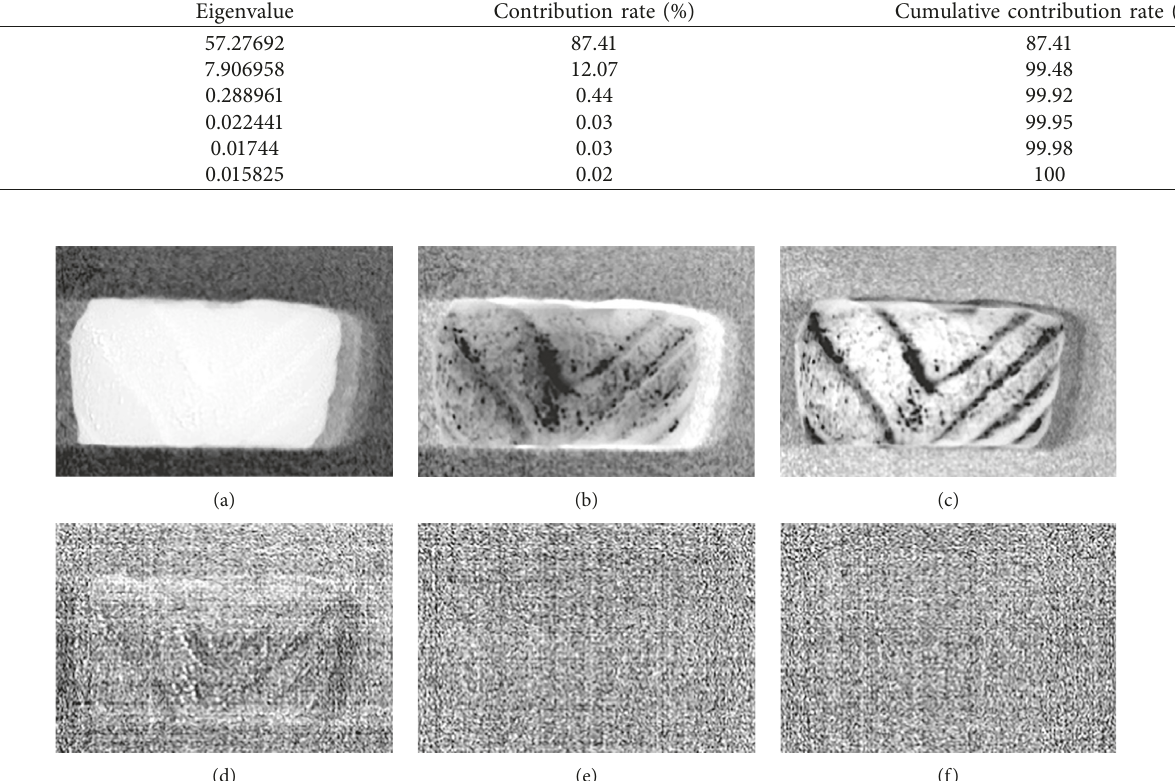
Figure 2: The first six principal-component images of the salmon sample with 0.3 mL of water injected: (a) PC1, (b) PC2, (c) PC3, (d) PC4, (e) PC5, and (f)